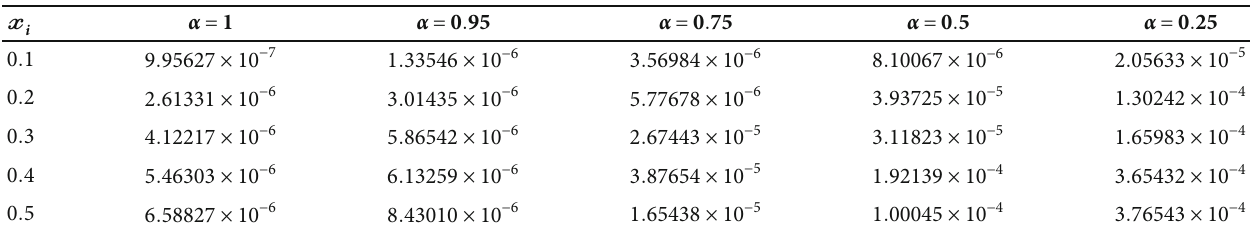
ff erent values of fractional order α at t = 0 : 2, λ = 1 of FGEs (21) and Table 2: Absolute errors j u − u 3 j for di